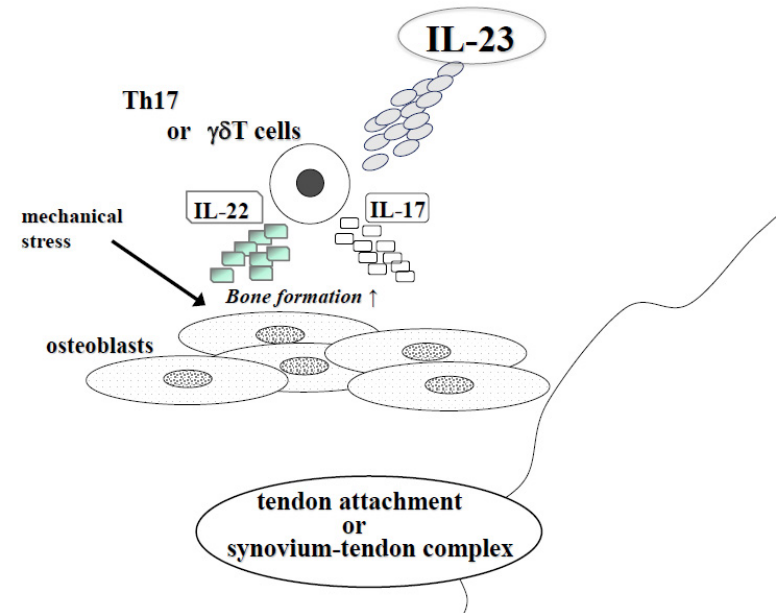
Figure 2. The effect of IL ‐ 23 in SpA at tendon attachment or synovium ‐ tendon complex. In SpA, new bone formation develops at tendon attachment or synovium ‐ tendon complex. IL ‐ 23 induced IL ‐ 17 or IL ‐ 22 from Th17 or γδ T cells and especially IL ‐ 22 stimulates osteoblast differentiation. At these sites, mechanical stress also stimulated bone formation.